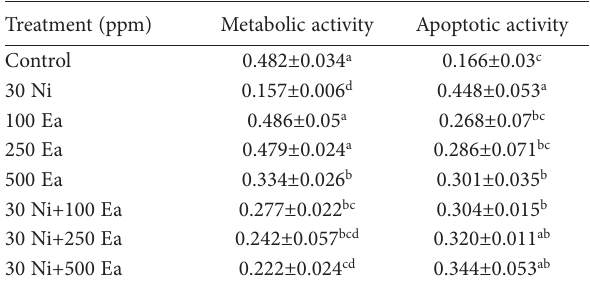
Table 5. Metabolic and apoptotic activities of A. cepa root tips after treatment with Ni, encapsulated E. acoroides leaves extract and combined Ni and encapsulated